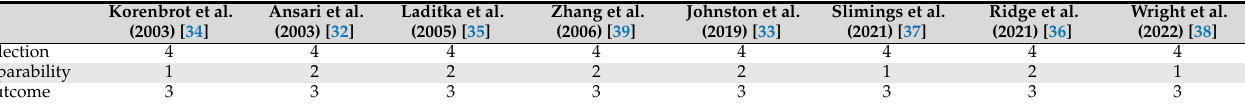
Table 4. CASP rating for qualitative papers.